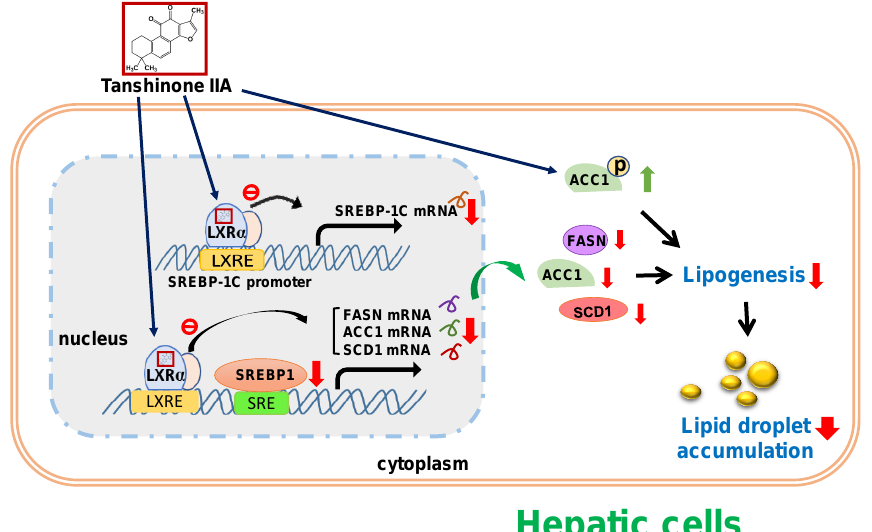
Figure 10. A hypothetical model for the tanshinone-IIA-mediated attenuation of lipid accumulation in hepatic cells. Tanshinone IIA promotes ACC1 phosphorylation to attenuate fatty-acid synthesis and lipogenesis. Tanshinone IIA down-regulates FASN, ACC1, and SCD1 expression by inhibiting the LXR α -mediated transcriptional activation, resulting in a reduction in endogenous and fatty-acid-induced lipogenesis as well as lipid-droplet accumulation in hepatic cells.